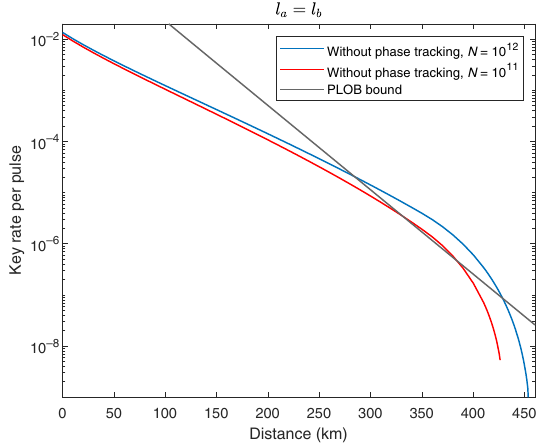
FIG. 6. The bit error rate in the X basis as a function of the matching time interval T c , where both phase tracking and phase locking are not adopted. The distance between Alice and Bob is 300 km and the system repetition rate is F = 4 GHz. The frequency difference δv is set to 10, 50, and 100 kHz.